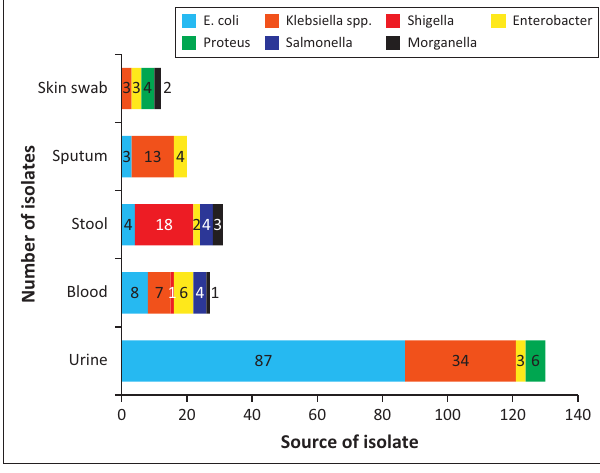
FIGURE 1: Commonest Enterobacteriaceae isolates and sites cultured from.